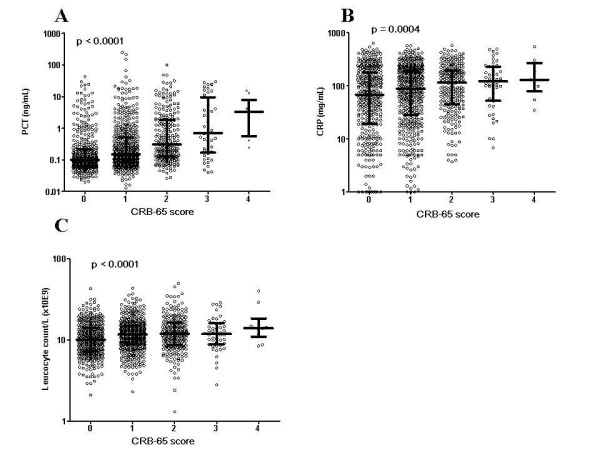
Admission levels of PCT (a), CRP (b) and WBC (c) in CAP patients classified into CRB-65 classes 0–4. The scatterplots represent all data. Median values with interquartile ranges are shown. Results of Kruskal-Wallis one-way analysis of variance are shown. ns = no significant difference.